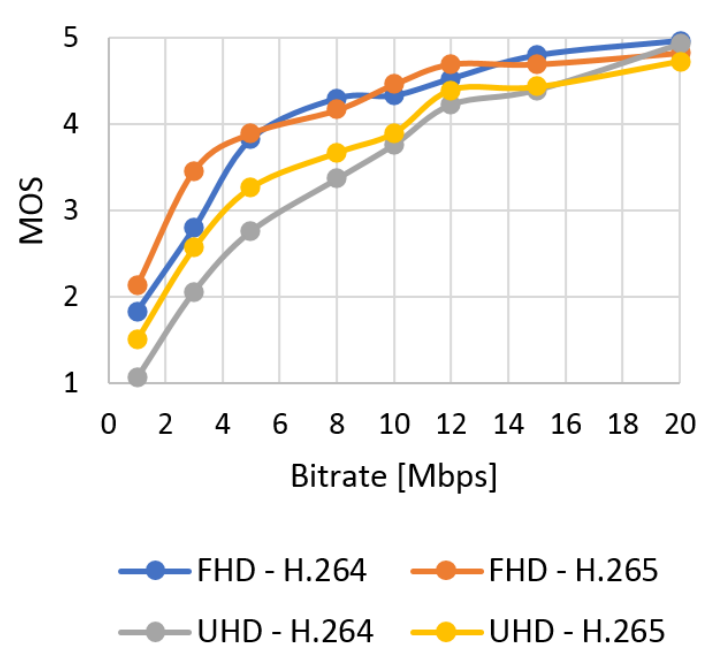
Figure 13. Wood, subjective